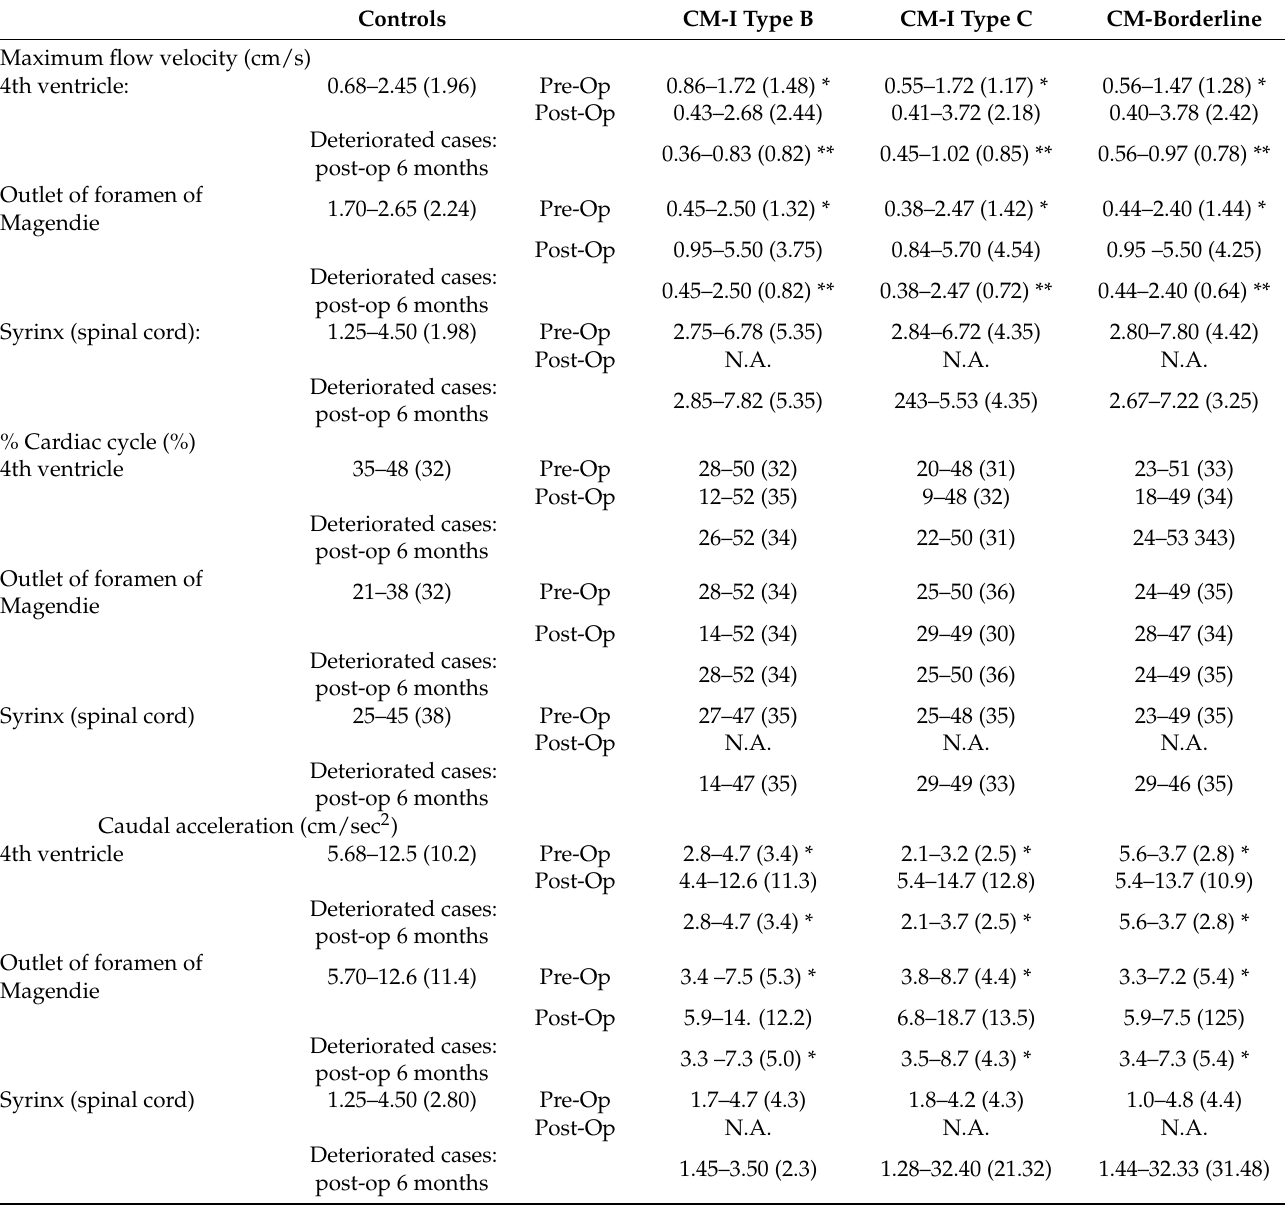
Table 6. Results of analyses of CSF flow dynamics using Cine PC